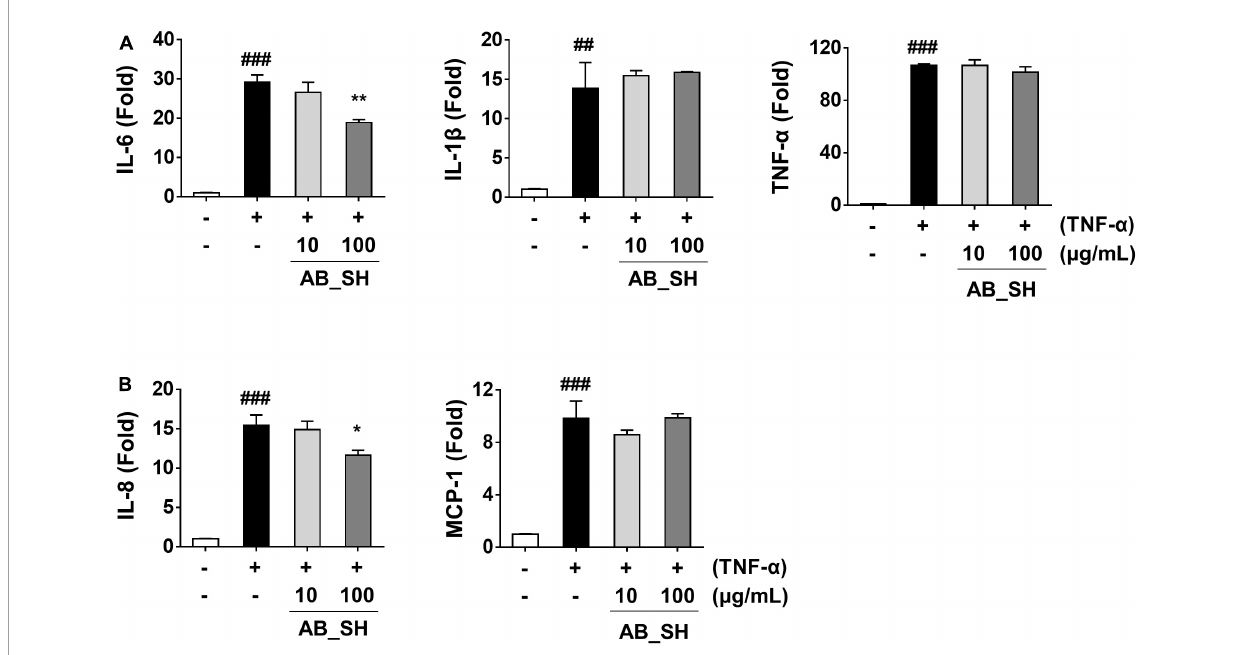
FIGURE2 Effect of AB_SH on mRNA expression of cytokines and chemokines in TNF- α -stimulated ARPE-19 cells. ARPE-19 cells were pre-treated with AB_SH for 1 h and subsequently stimulated with 50 ng/mL TNF- α for 1 h. The mRNA expression was analyzed by real-time RT-PCR. mRNA expression levels of (A) the cytokines IL-6, IL-1 β , and TNF- α and (B) the chemokines IL-8 and MCP-1. The values represent the mean ± SD of three independent experiments. ## p < 0.01 and ### p < 0.001 compared with the control. * p < 0.05 and ** p < 0.01 compared with the TNF- α -treated control,